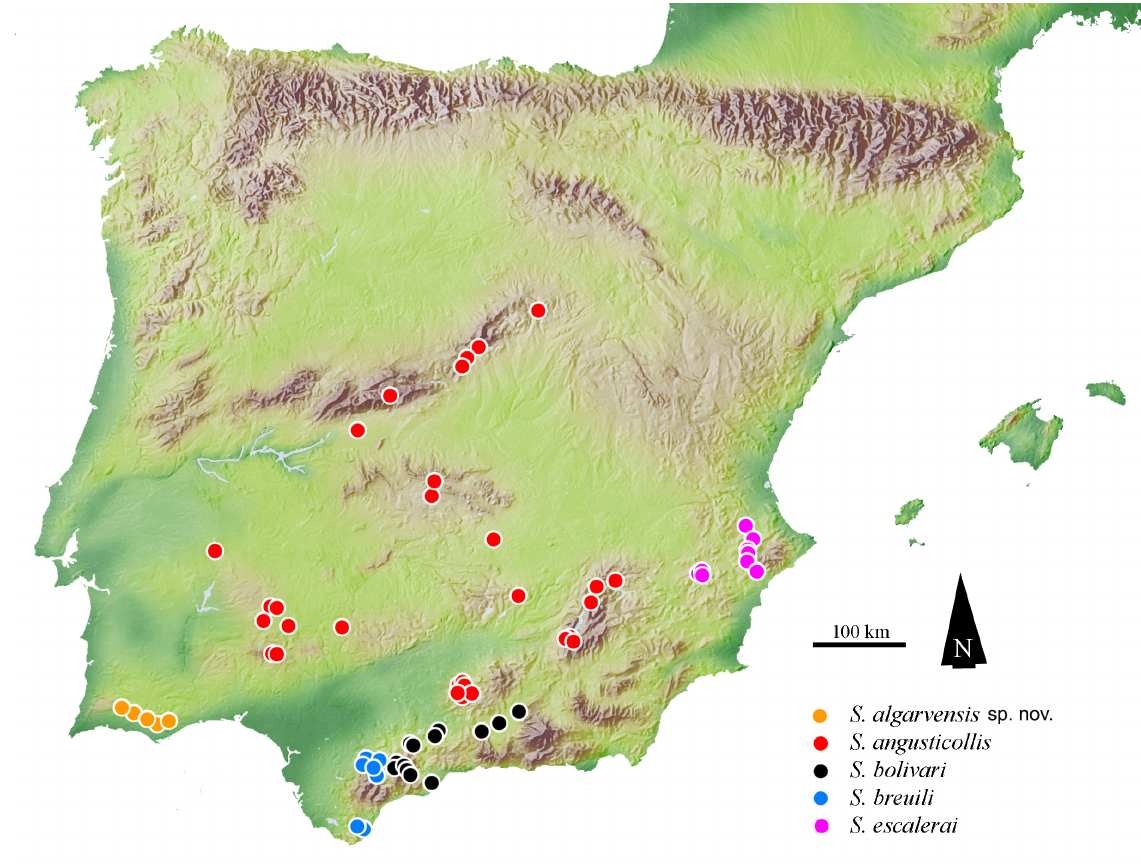
Fig. 32. Distribution of Speonemadus of the escalerai -group: S. algarvensis sp. nov., S. angusticollis (Kraatz, 1870), S. bolivari (Jeannel, 1922), S. breuili (Jeannel, 1922) and S. escalerai (Uhagón,